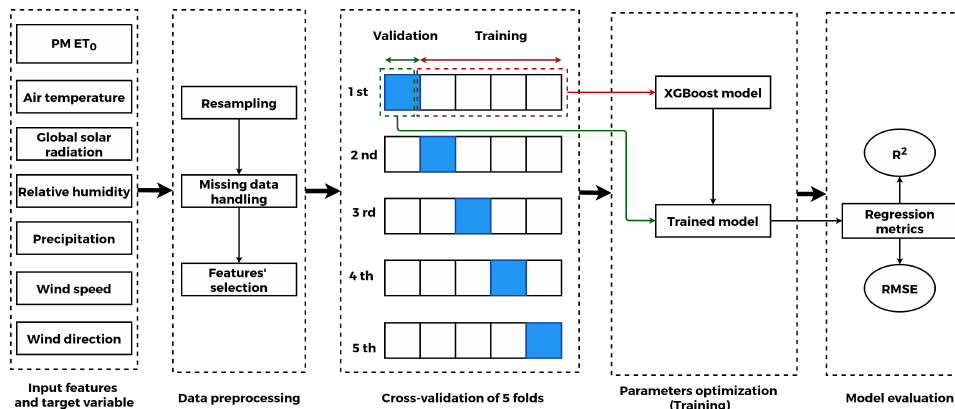
Figure 9. The flowchart of the proposed method.